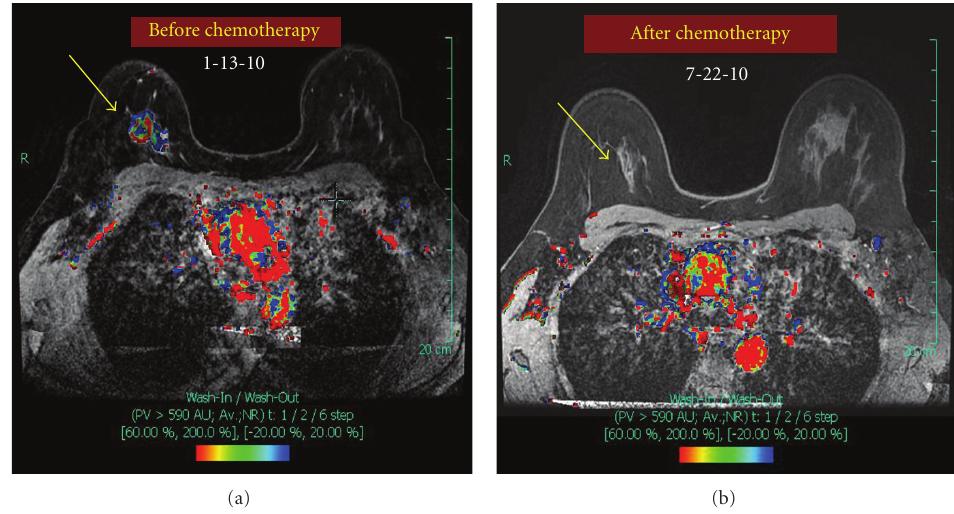
Figure 3: Comparison of bilateral breast MRI studies performed before and after neoadjuvant chemotherapy. (a) Doppler flow MRI before neoadjuvant chemotherapy. Yellow arrow points to the 2.7cm irregular mass in the right breast. (b) Doppler flow MRI after neoadjuvant chemotherapy shows complete radiologic response. Yellow arrow points to area where the mass was located prior to